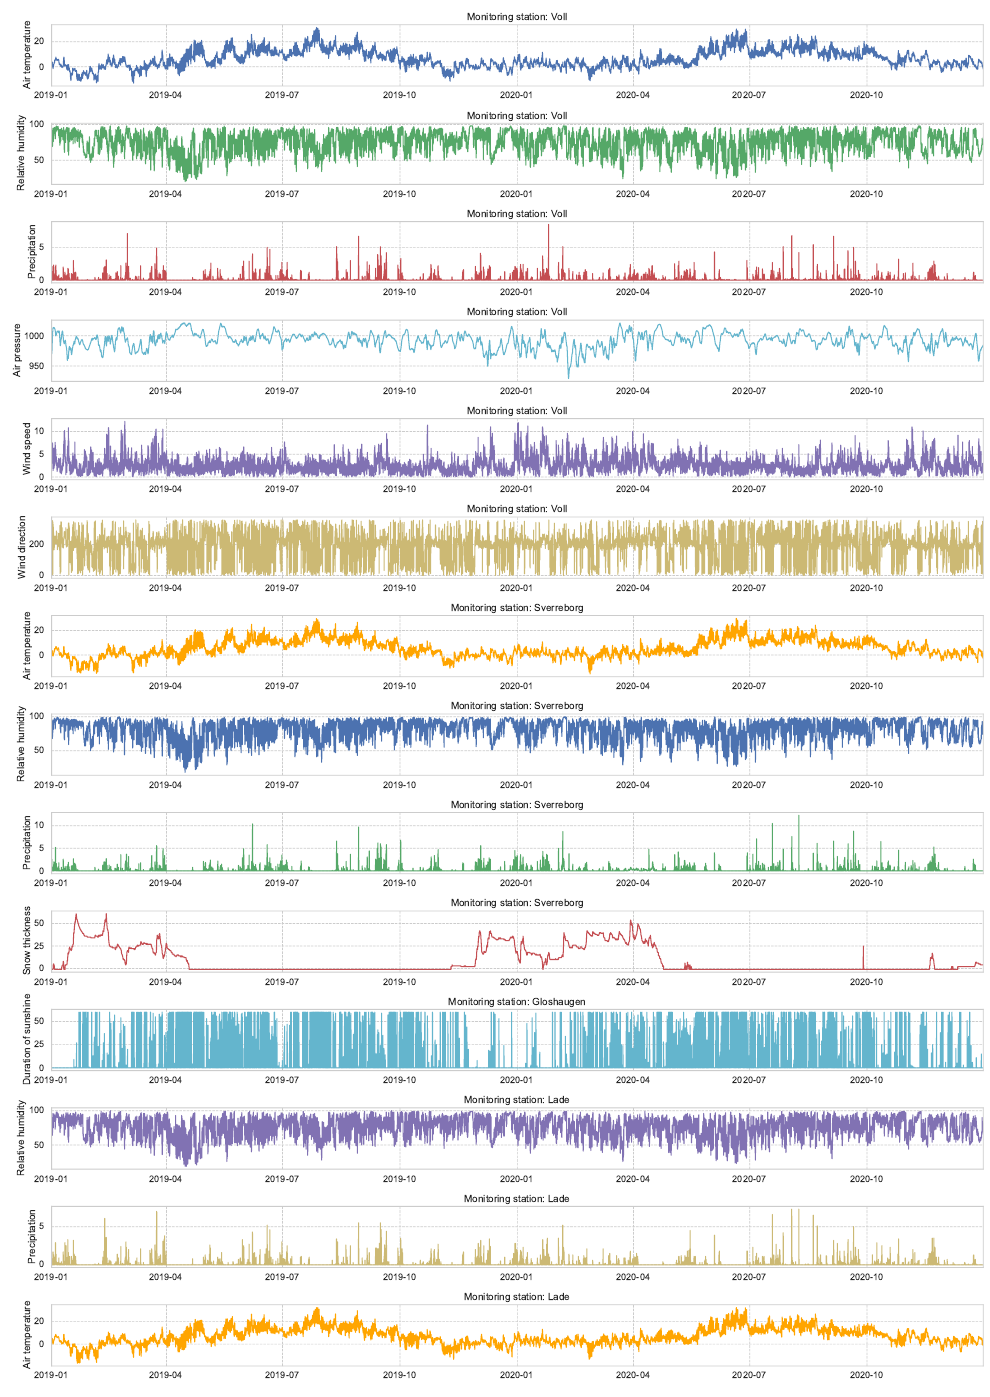
Figure A2. Weather data observations over two years at four monitoring station in the city of Tronde- heim (Voll, Sverreborg, Gloshaugen, Lade). These data are offered by the Norwegian Meteorological Institute (https://frost.met.no, accessed on 27 November